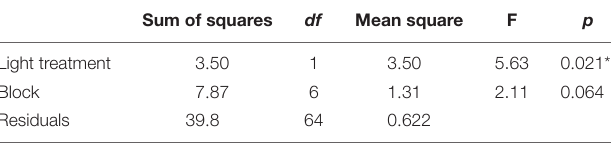
lux; Poulin et al., 2014), and light as low as 3.5 lux has induced